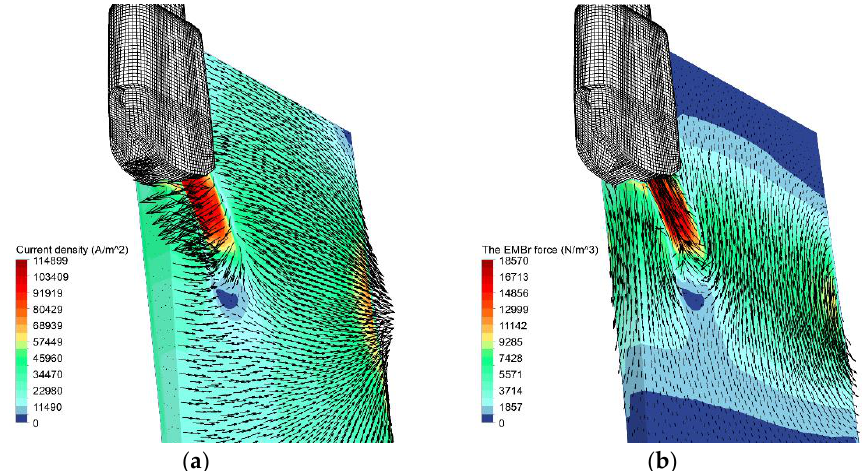
Figure 6. ( a ) The magnitude and direction of the induced current density arising from EMBr. ( b ) The magnitude and direction of the EMBr force.